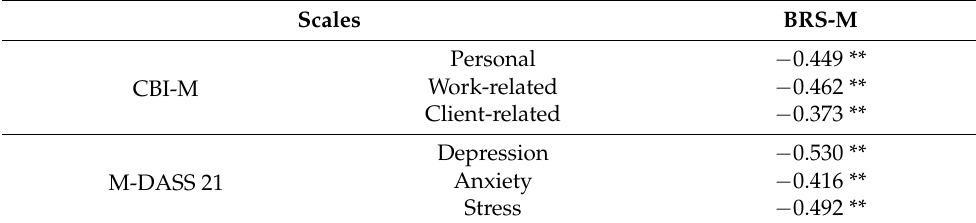
Table 2. Pearson correlations between the BRS-M with CBI-M and M-DASS-21.